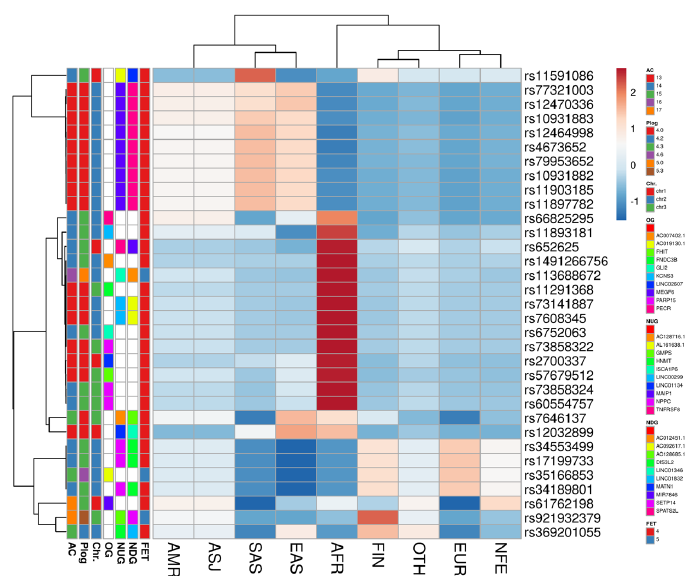
Figure 11. The clustering analysis of hypertension-associated SNPs ( ≤ 4 log- p value) across different ethnic groups. The SNP identity number (SNPID), maximum allele count (AC), EH association log- p value score, chromosome (Chr), overlapped gene (OG), nearest upstream gene (NUG), and nearest downstream gene